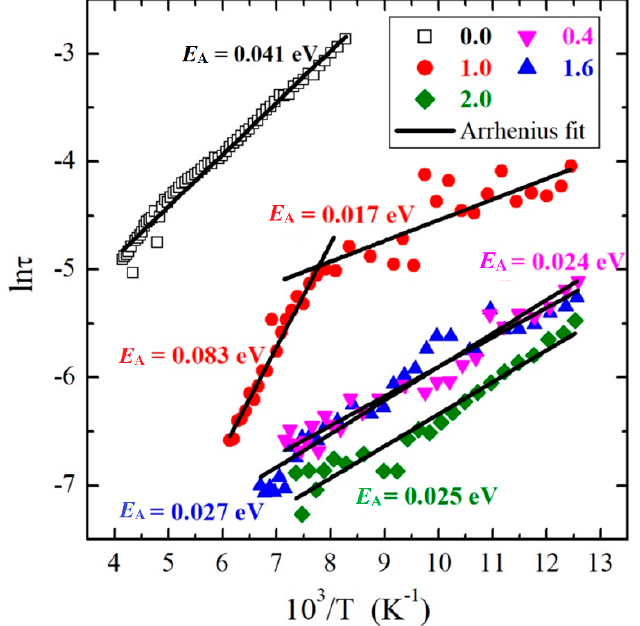
Figure 11. ε ’’(v) spectra with fitting function for samples with x = 2.0 (upper panel) and 0.0 (lower panel).